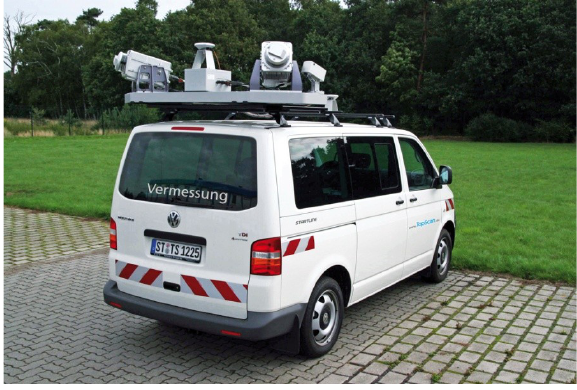
Figure 2. Lynx M1 integrated by TopScan (DE)